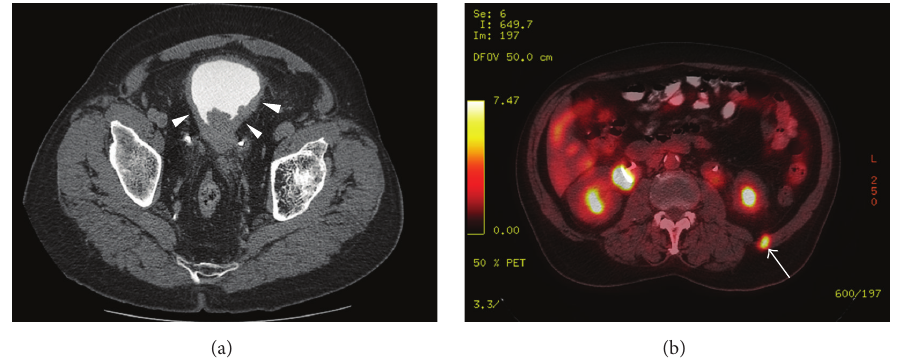
Figure 1: Imaging studies: (a) CT of the abdomen and pelvis showing diffuse bladder wall thickening ( arrowheads ) with perivesical fat stranding, indicating involvement of the bladder by invasive carcinoma; (b) PET of the abdomen and pelvis showing a 1cm FDG-avid nodule in the musculature of the left flank, suspicious for metastasis ( arrow ).